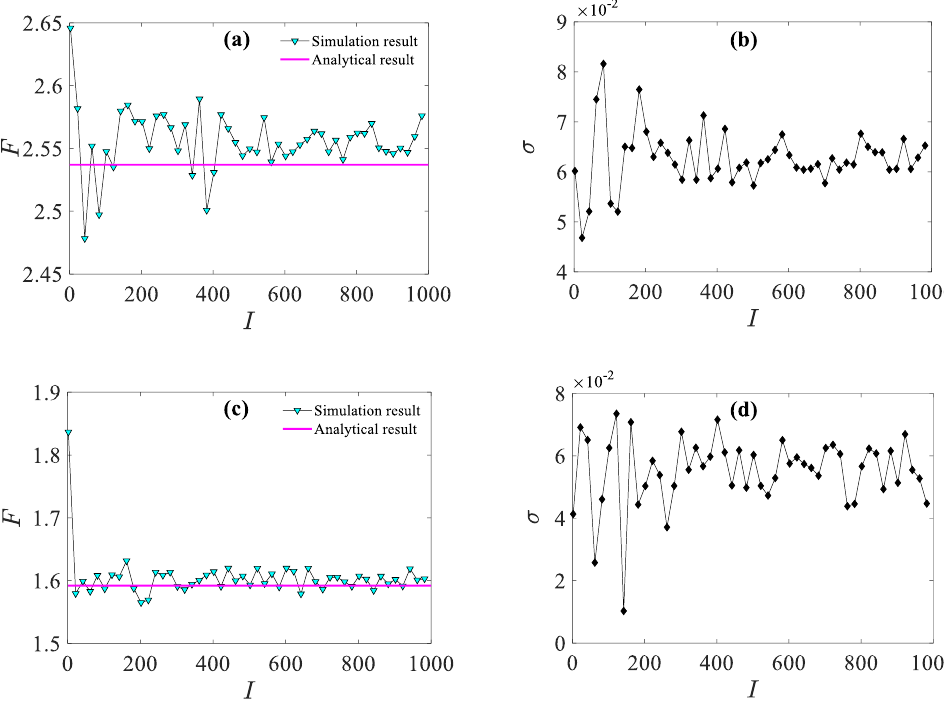
Figure 19. Effect of samples on numerically simulated results of output steady-state amplitude and MSE. ( a , b ) ∆ 2 = 0.1, ( c , d ) ∆ 2 = 1.